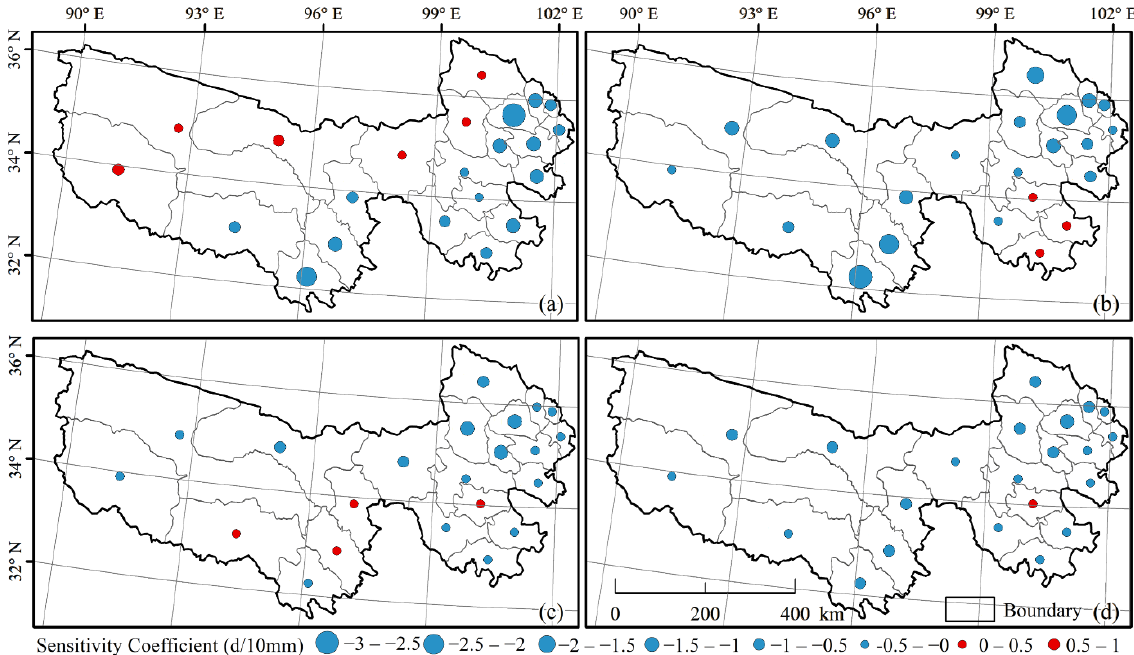
Figure 11. Spatial distribution of the sensitivity coefficients between the SOS of the vegetation and precipitation in March ( a ), April ( b ), May ( c ) and March – May ( d ) in the Three-River headwaters region.